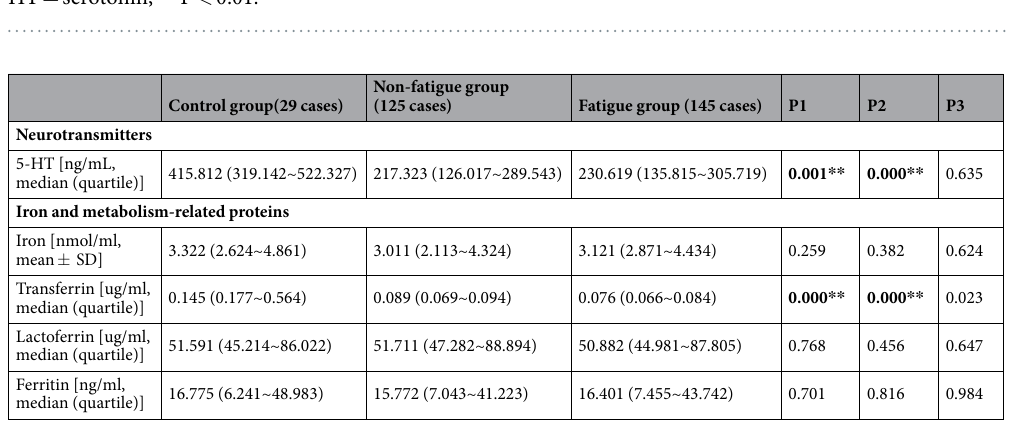
Table 4. The levels of 5-HT, iron and metabolism-related proteins in serum among control, non-fatigue and fatigue groups. 5-HT = serotonin; P1: non-fatigue group vs. control group; P2: fatigue group vs. control group, P3: non-fatigue group vs. fatigue group. ** P <